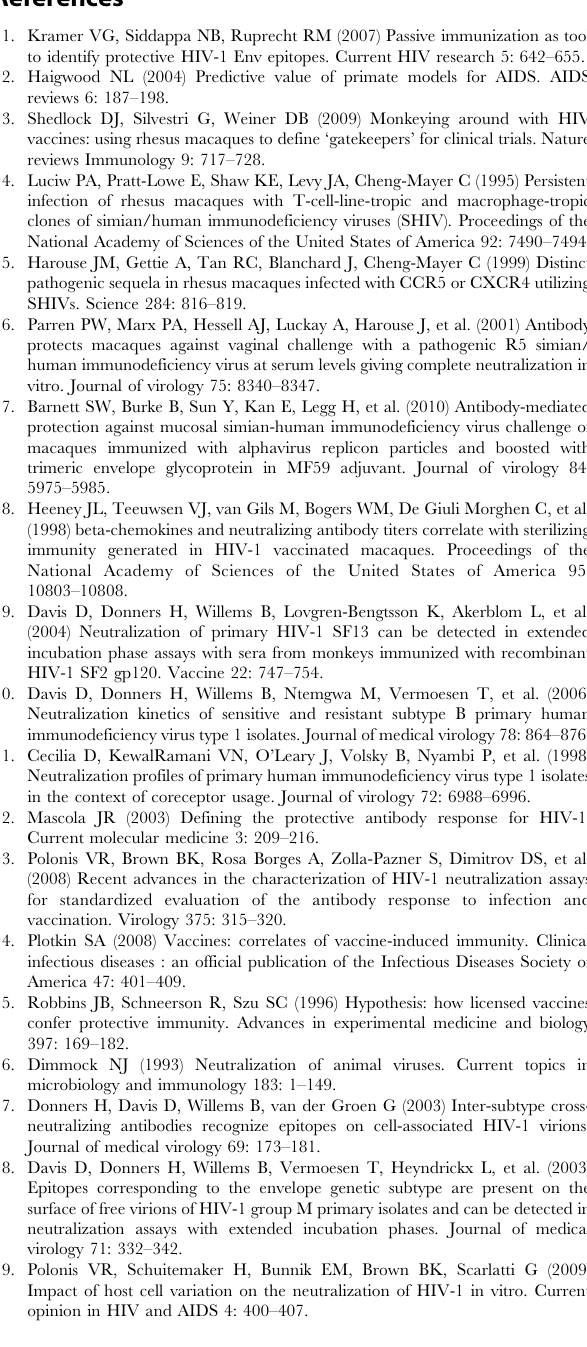
Table S1 Outline of immunization schedules for five rhesus macaque immunogenicity and SHIV SF162P4 challenge